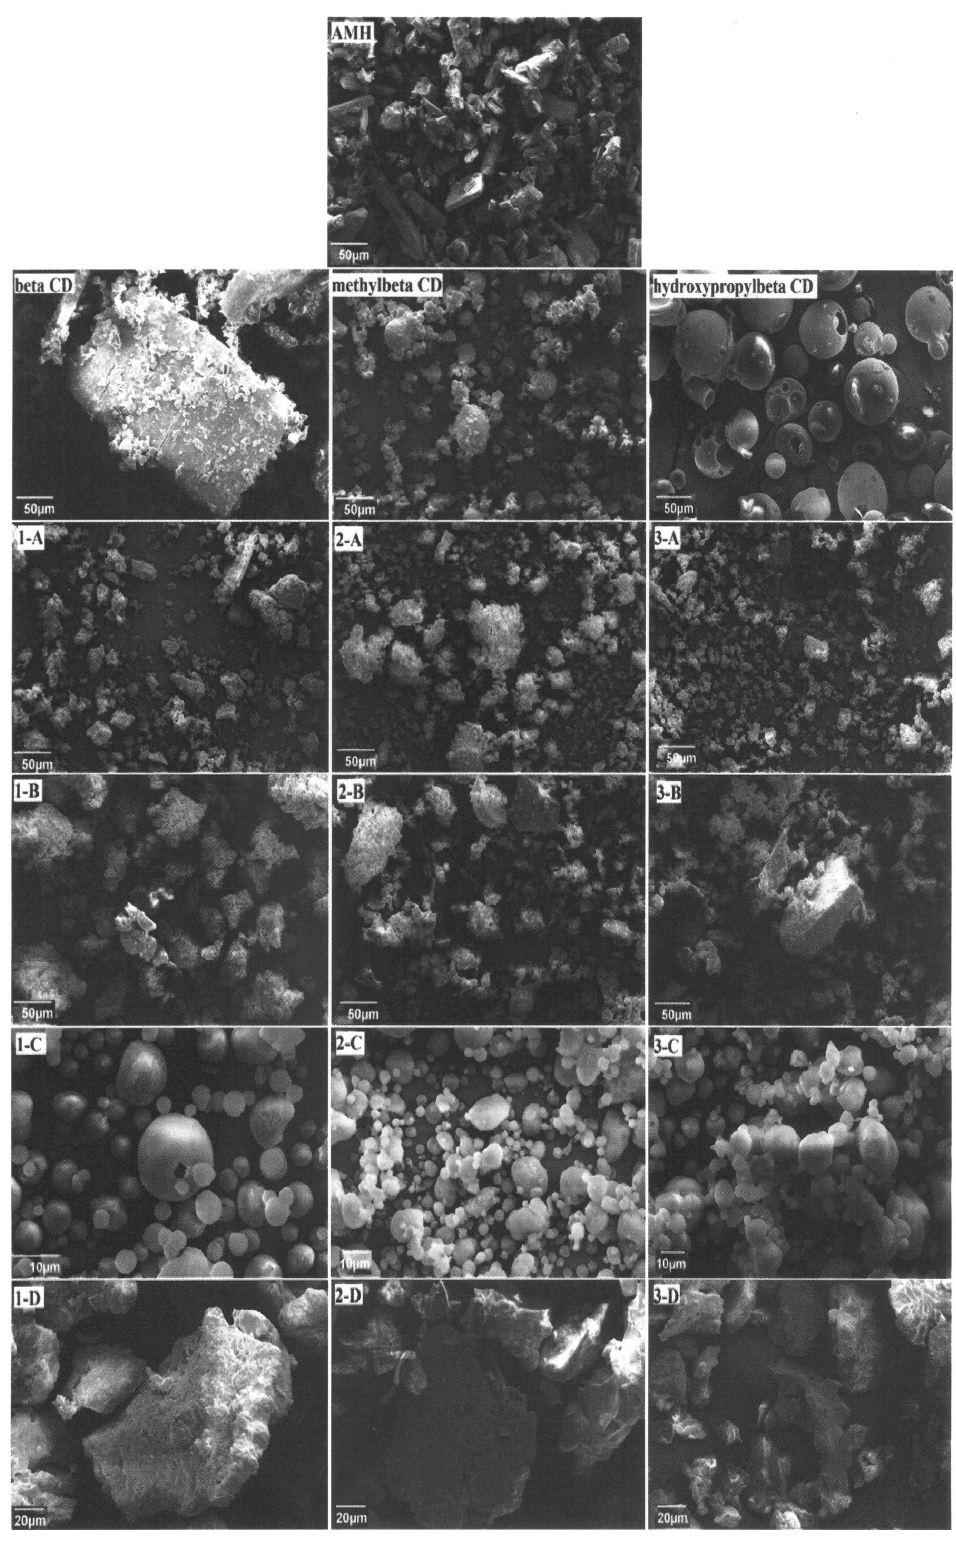
FIGURE 4 - Scanning Electronic Microscopy of AMH, beta-CD, methylbeta-CD, hydroxypropylbeta-CD, AMH/beta-CD/PM (1A), AMH/beta-CD/CE (1B), AMH/beta-CD/SD (1C), AMH/beta-CD/FD (1D), AMH/methylbeta-CD/PM (2A), AMH/methylbeta- CD/CE (2B), AMH/methylbeta-CD/SD (2C), AMH/methylbeta-CD/FD (2D), AMH/hydroxypropylbeta-CD/PM (3A), AMH/ hydroxypropylbeta-CD/CE (3B), AMH/hydroxypropylbeta-CD/SD (3C) and AMH/hydroxypropylbeta-CD/FD